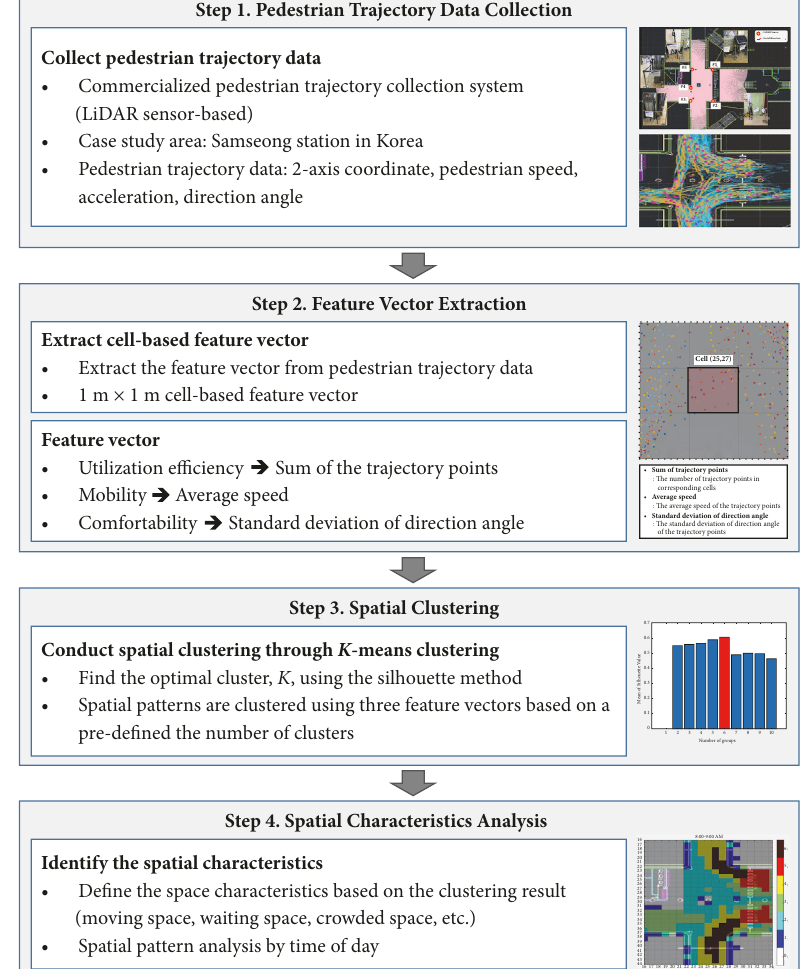
Figure 1: Overall framework of this study outlining the procedure’s four sequential steps: (1) pedestrian trajectory data collection, (2) feature vector extraction, (3) spatial clustering, and (4) spatial characteristics analysis.